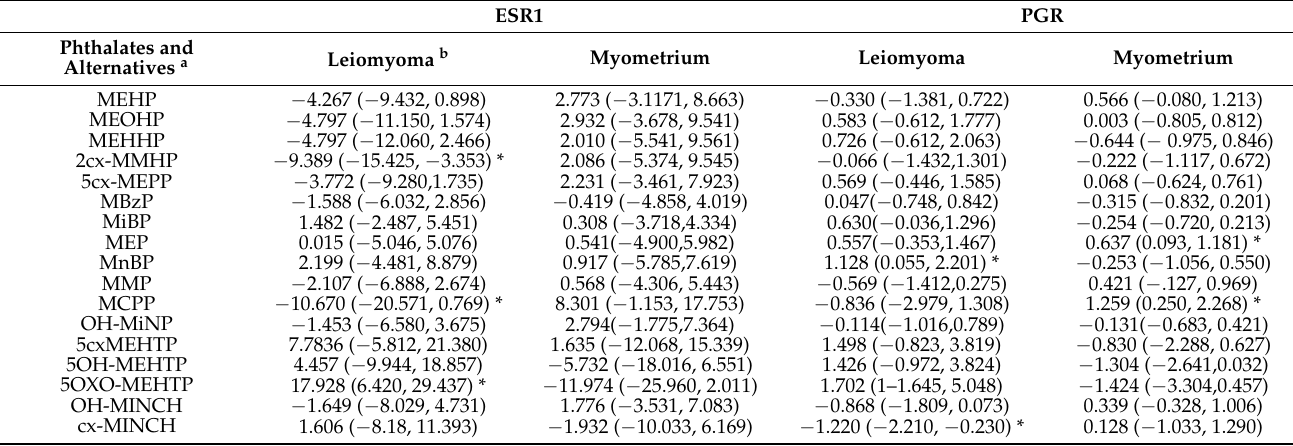
Table 3. Association of phthalate and alternative plasticizer metabolites with ESR1 and PGR methylation in leiomyoma and myometrium